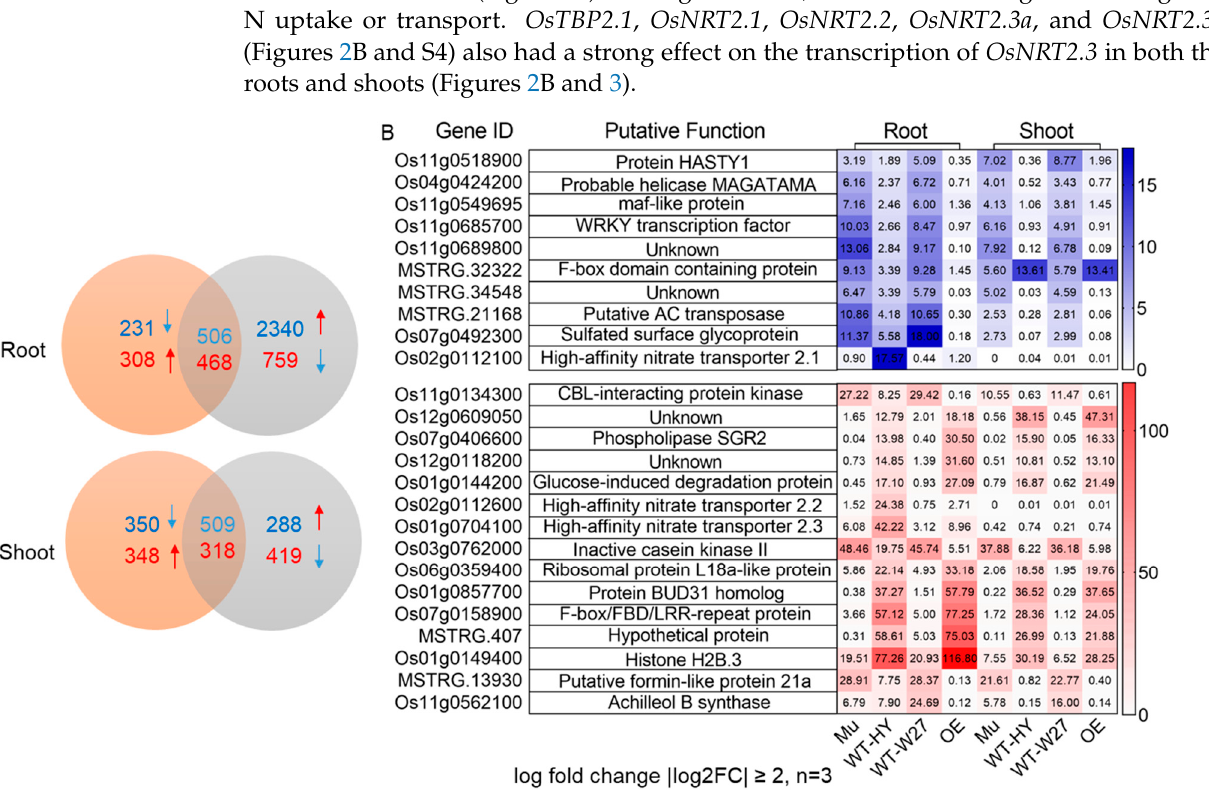
4 of 14 Figure 1. Phenotype of OsTBP2.1 T-DNA insertion mutant and OsTBP2.1 overexpression lines. ( A ) Characterization of T-DNA insertion mutant lines ( ostbp2.1 , 1A-19324 and 2B-30161) and OsTBP2.1 overexpression lines (OE, OE198 and OE399) in a field experiment. Wild-type, Huangyang (WT-